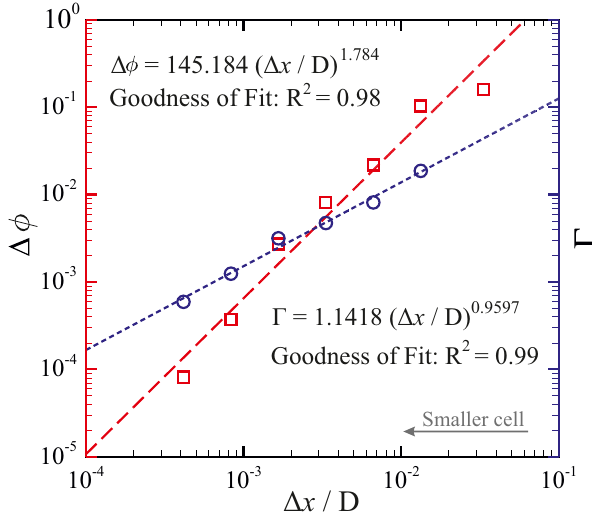
Figure 5. The relative difference between the solid–liquid interface morphologies ( Γ (defined in Equation (13)), circles in blue), and the relative difference between the liquid fractions ( ∆ φ (defined below Equation (12)), squares in red) at t = 150s when using permeability coefficients C 1 = 1 × 10 8 kgs − 1 m − 3 and C 2 = 1 × 10 4 kgs − 1 m − 3 as a function of grid size ( ∆ x ). Larger values of ∆ φ and Γ indicate more sensitivity to the value of the permeability coefficient C . Symbols: results obtained from numerical simulations; dashed lines: curve-fit.